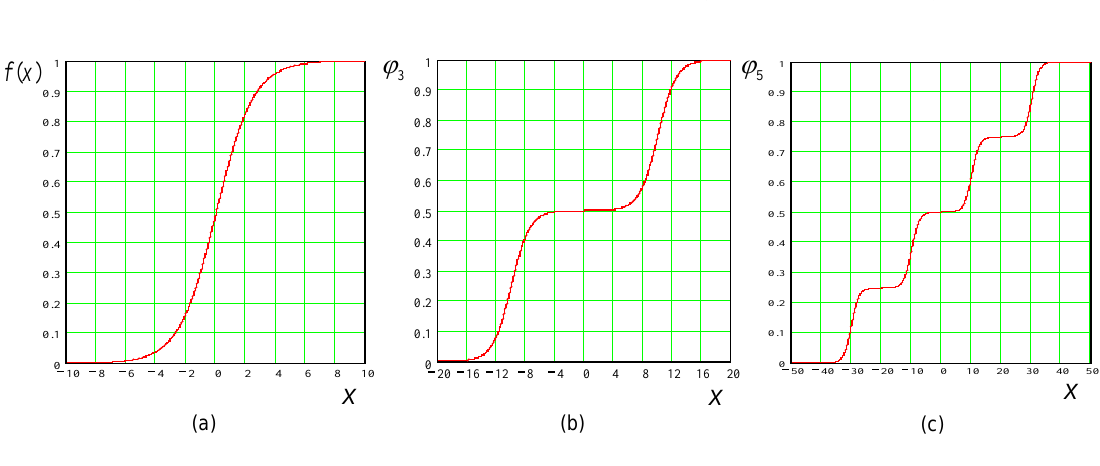
Figure 6. Standard sigmoidal function and its multilevel versions: ( a ) Sigmoidal function; ( b ) Multi-level function for r = 3; ( c ) Multi-level function for r =